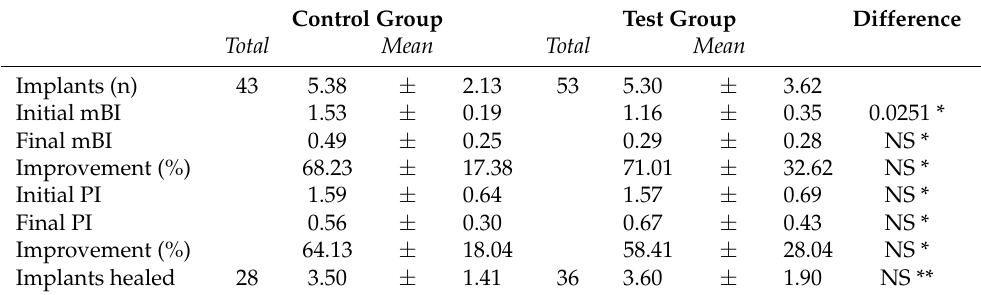
Table 2. Summary of prosthesis data. Table 3.